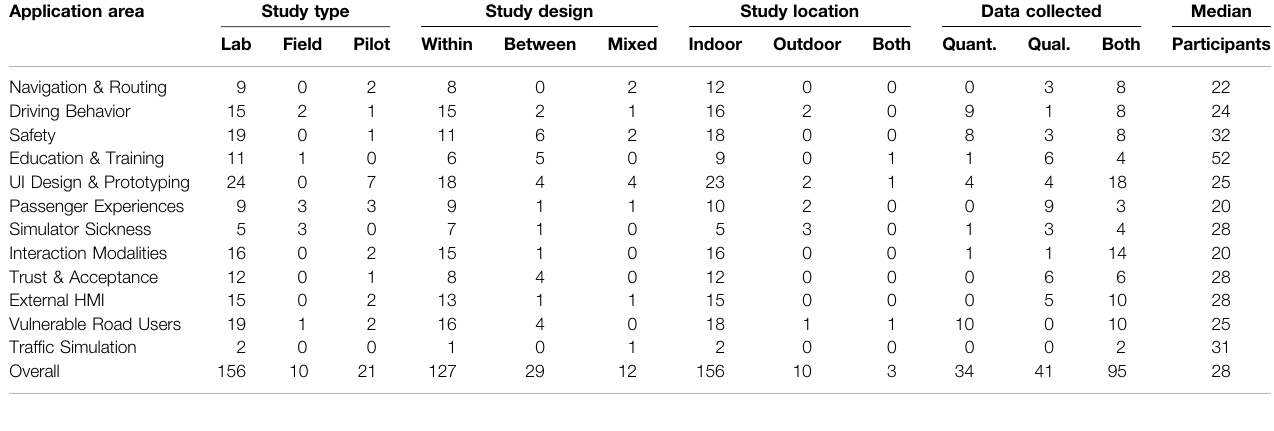
TABLE 2 | Summary of the user studies reported by the 176 reviewed papers. Application area